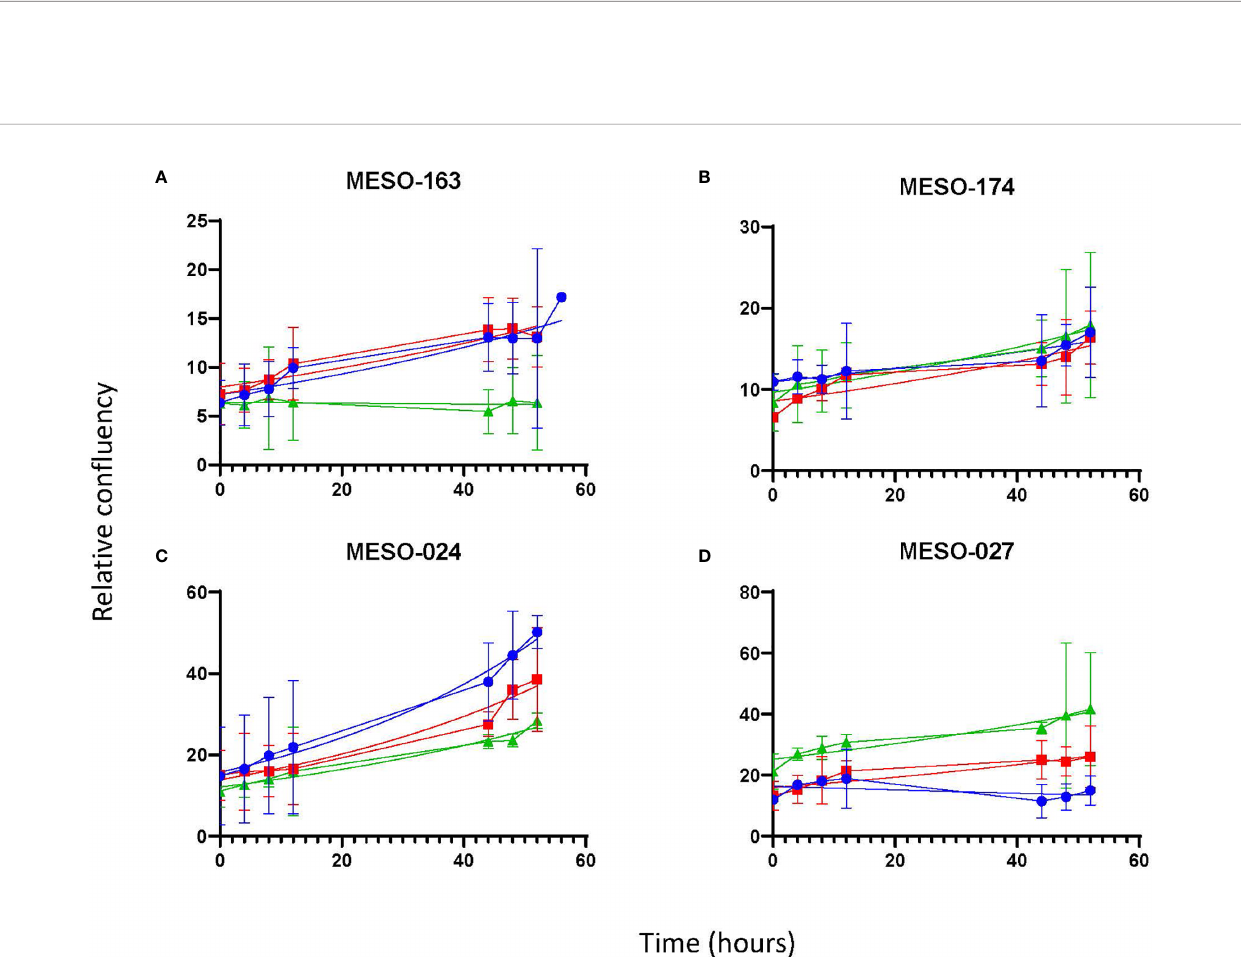
FIGURE 3 | The growth curves for cells from MPM cell cultures in vitro , seeded directly in pleural fl uid. The curves show the mean and 95% con fi dence intervals, and a trendline for non-linear fi t. Cell cultures: (A) MESO-163 (epithelioid MPM) , (B) MESO-174 (biphasic MPM) , (C) MESO-024 (biphasic MPM) , and (D) MESO-027 (epithelioid MPM). HF, heart failure; MPE, malignant pleural effusion; MPM, malignant pleural